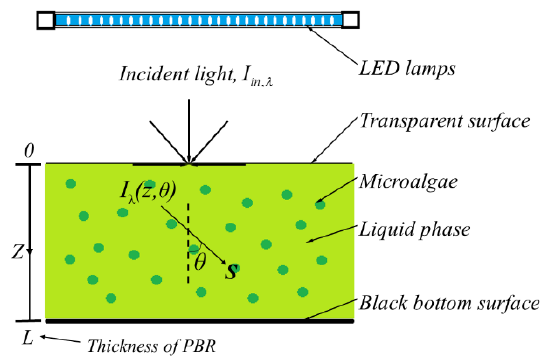
Figure 1. The schematic of the photobioreactor system.